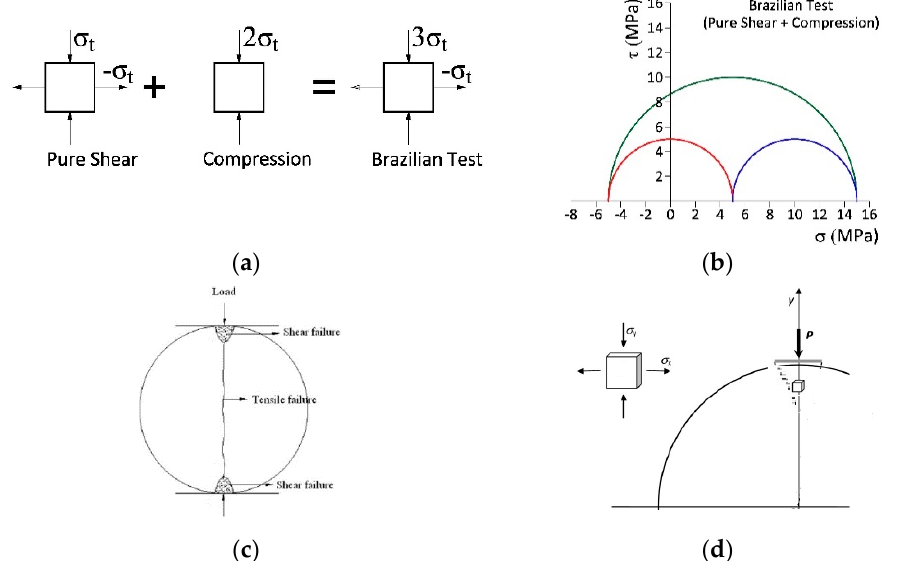
Figure 1. ( a ) Block diagram showing Brazilian test as composed of pure shear with the radius of τ = σ t and uniaxial compression of σ c = 2 σ t ; ( b ) Mohr circles showing the Brazilian test (blue circle), pure shear with the radius of τ = σ t (red circle) and uniaxial compression of σ c = 2 σ t (green circle). ( c ) Transition between shear and tensile failure modes in a solid disk in the Brazilian test (as illustrated by Hobbs). ( d ) Block diagram showing the state of shear stress under loading plates.